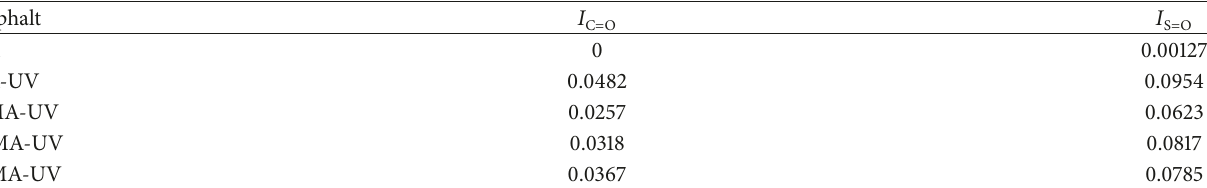
Table 3: 𝐼 C = O and 𝐼 S = O of UV aged and unaged asphalt.